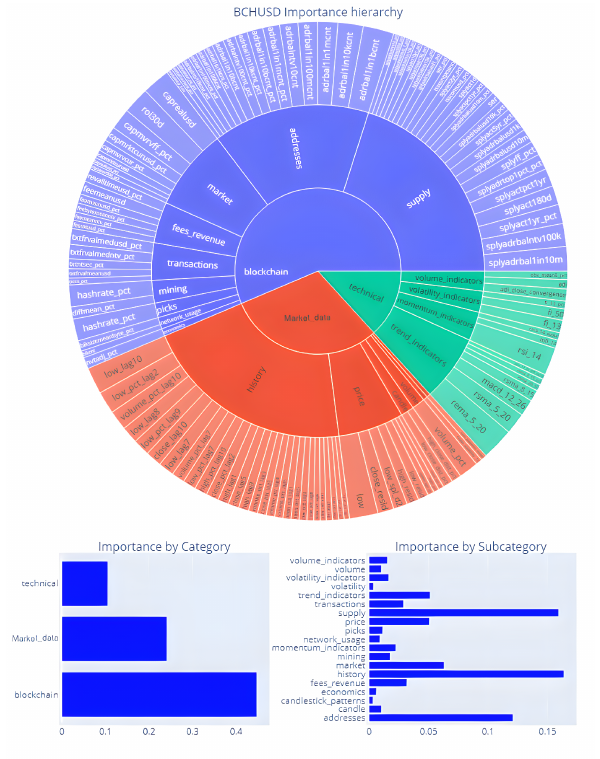
Figure 4. Hierarchical mean feature importance for